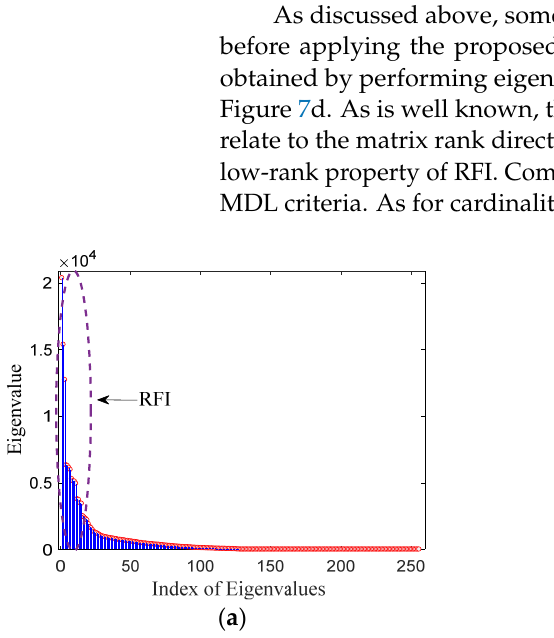
Figure 7. Representations of the simulated RFI-contaminated SAR echo signal. ( a , b ), the RFI-corrupted SAR echo in the time and frequency domains, respectively; ( c ) original RFI-free signal; and ( d ) RFI-contaminated SAR echo in the TF domain.